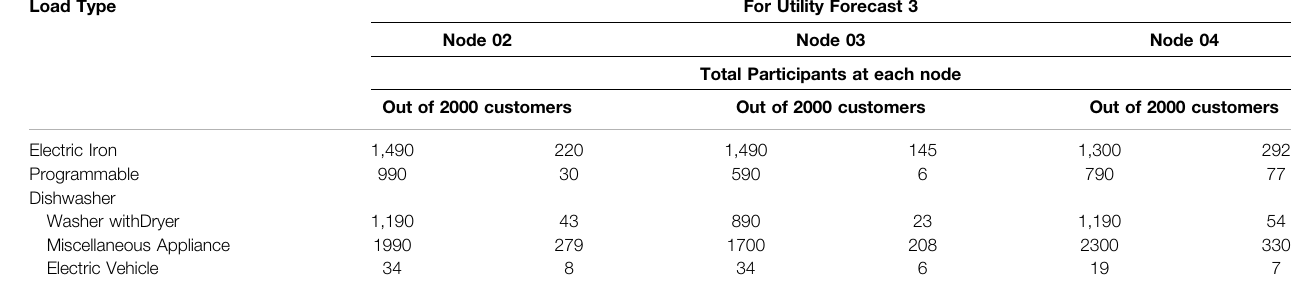
TABLE 5 | Number of reschedule forecasts in utility